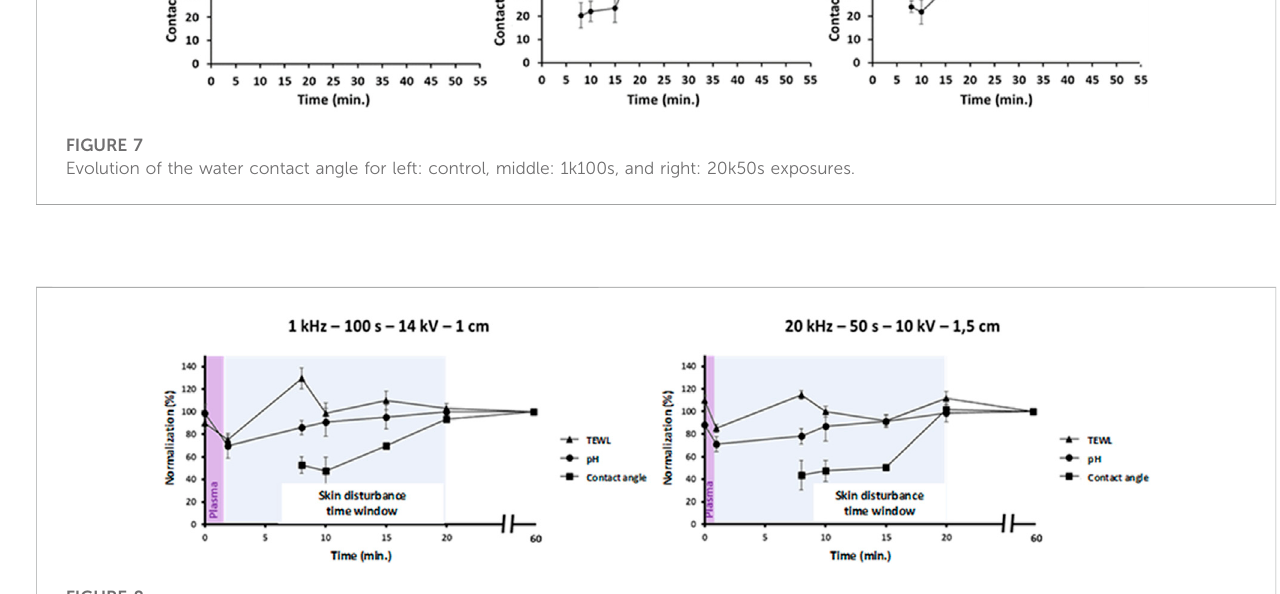
diagnostic method. In Ref. [47], caffeine HPLC detection using a Franz cell setup but equipped with a dermatomized pig skin sample between donor and receptor chambers was reported to be of 0.8 μ g/